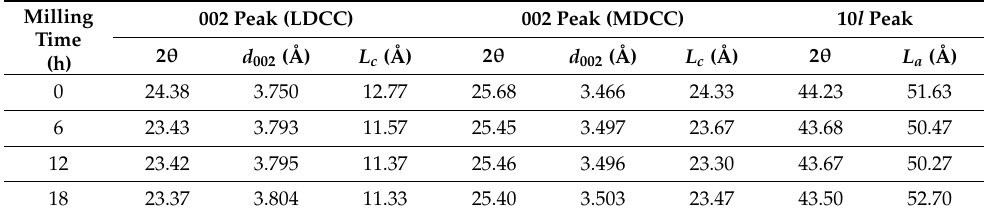
Table 1. XRD structural factors of mPCFs depending on milling time [13].